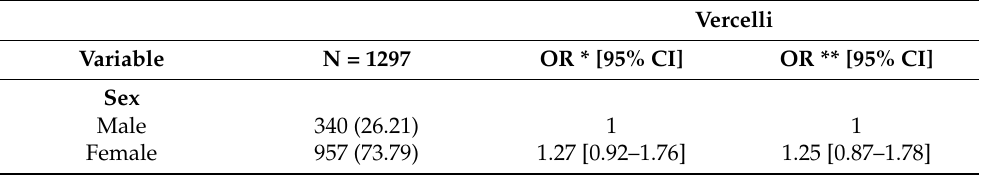
Table A1. Univariable (*) and multivariable (**) logistic models (outcome = seroprevalence) separately for Vercelli and Borgosesia hospitals. Odds ratios and 95% confidence intervals are